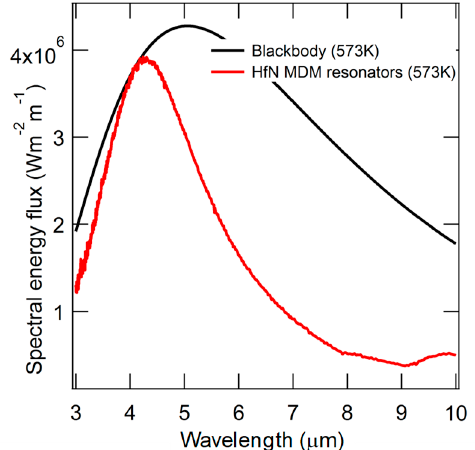
Figure 14. Calculated thermal radiation spectra at 573 K: The radiation spectrum from the MDM metasurface (red line) is calculated from the measured emissivity shown in Figure 13b. The theoretical blackbody radiation spectrum (Equation (1)) at 573 K (solid line) is plotted for reference.